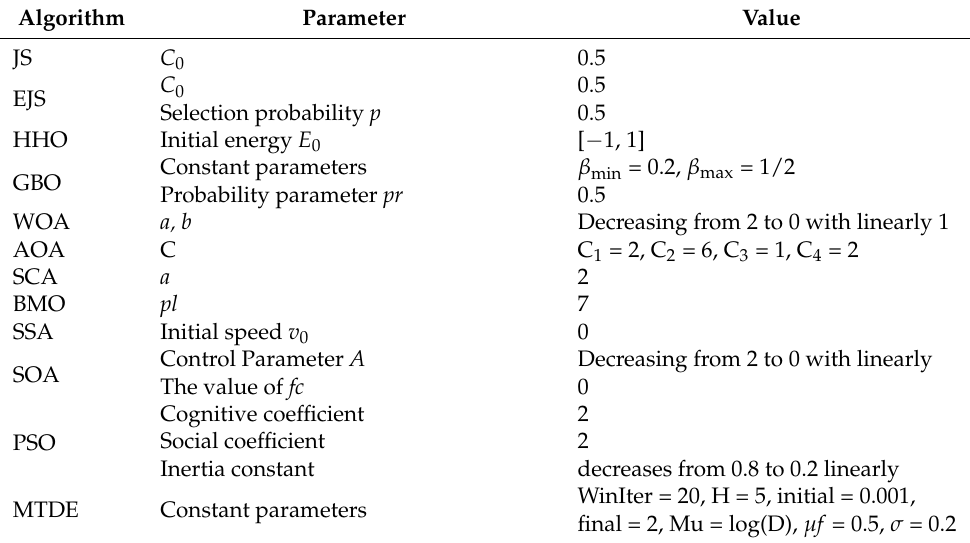
Figure 3. Convergence curves of the incomplete improved algorithms (some test sets). Table 3. Related parameters of other recognized